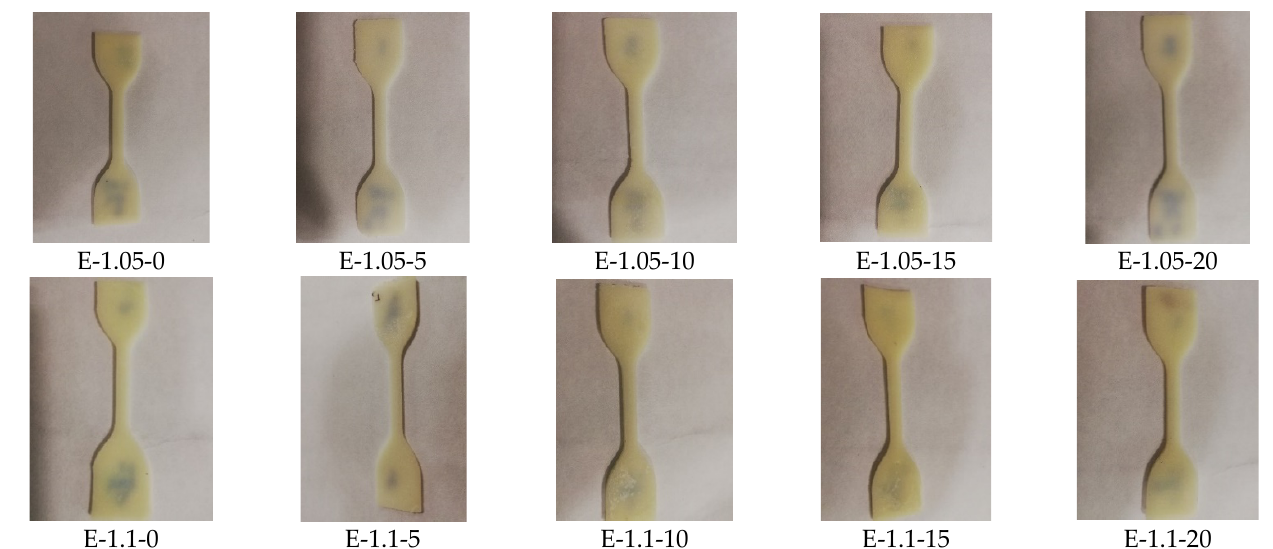
Figure 1. Appearance of the synthesized elastomers with different [NCO]/[OH] and mSD-(LDPE·EVA-RT27) contents.